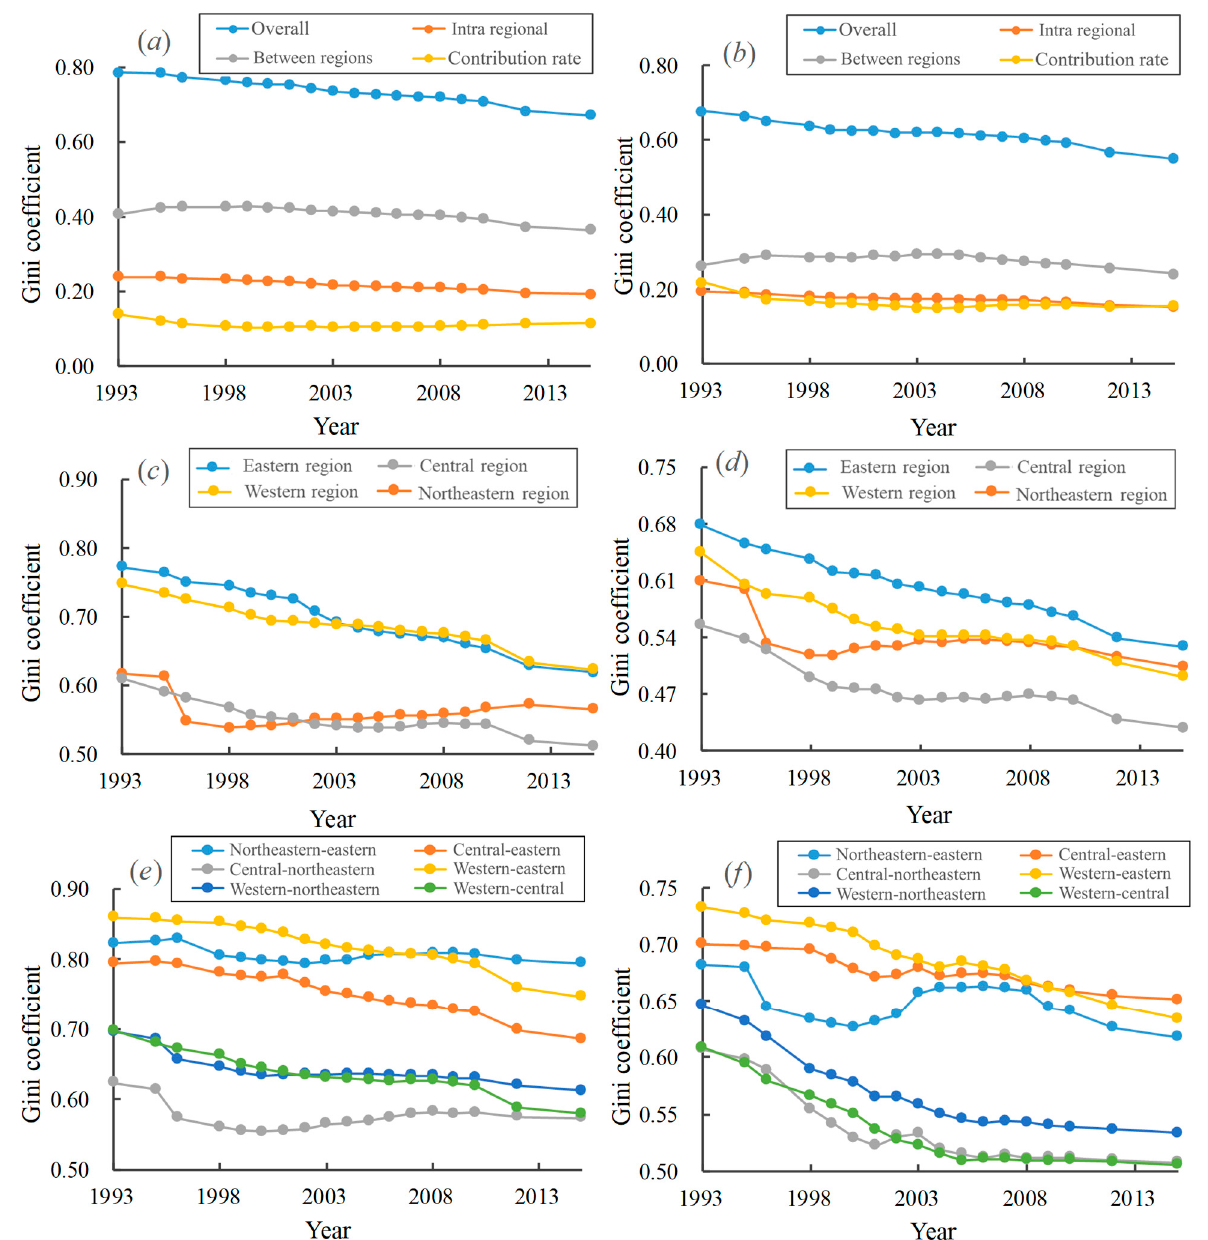
Figure 8. The results of the Dagum Gini coefficient; ( a , b ) are the overall Gini coefficient and contribution rate, respectively, ( c , d ) are intraregional, and ( e , f ) are between regions. In terms of intraregional differences (Figure 9), the evolutionary trend of the urban expansion Gini coefficient in the NER was not stable, showing a “U”-shaped change. The value of the Gini coefficient decreased significantly compared to that in 1995. This phenomenon occurred because the NER is a high-latitude region. Although there may be